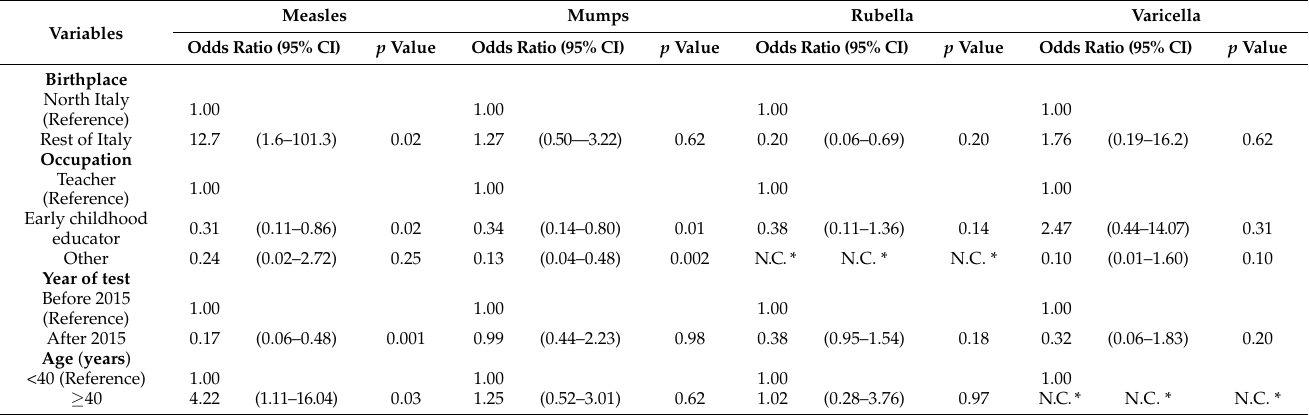
Table 3. Results of multi-variable logistic regression analysis. Relationship between workers’ characteristics and measles, mumps, rubella and varicella seropositivity was